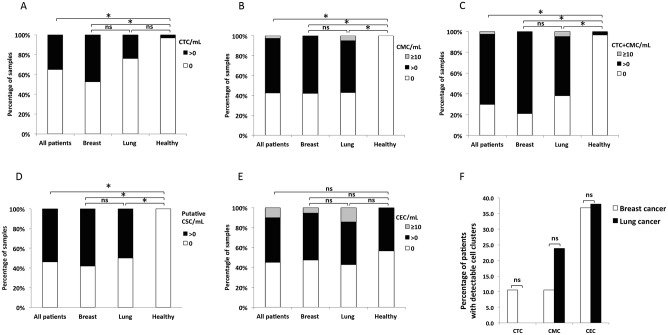
Detection of circulating rare cells in metastatic breast and lung cancer patients and healthy controls.Percentage of samples with detectable rare cells: A. circulating tumor cells (CTC), B. circulating mesenchymal cells (CMC), C. CTC and CMC, B. circulating mesenchymal cells (CMC), D. putative circulating stem cells (CSC), and E. circulating endothelial cells (CEC) in metastatic breast and lung cancer patients, and healthy controls. F. Percentage of patients with detectable cell clusters. Percent detection between groups was compared using Fisher exact tests and was considered significant (*) when p-value was <0.05, otherwise, not significant (ns).